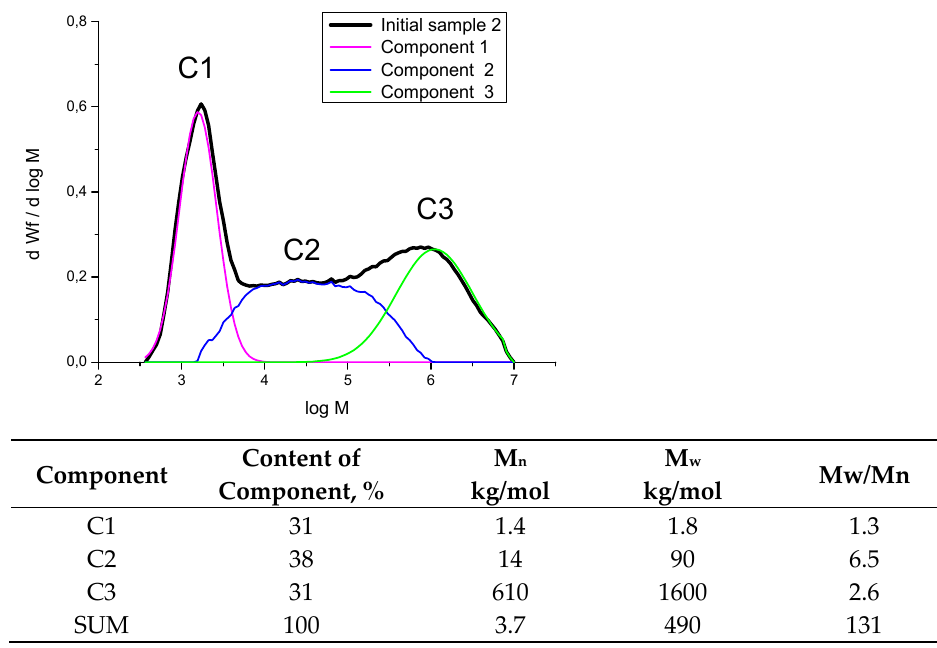
Figure 4. Data on the deconvolution of MWD curve for PE sample obtained from polymerization over the catalyst *LFeCl 2 /MMAO with TMA added into polymerization (exp. 2 in Figure 3).